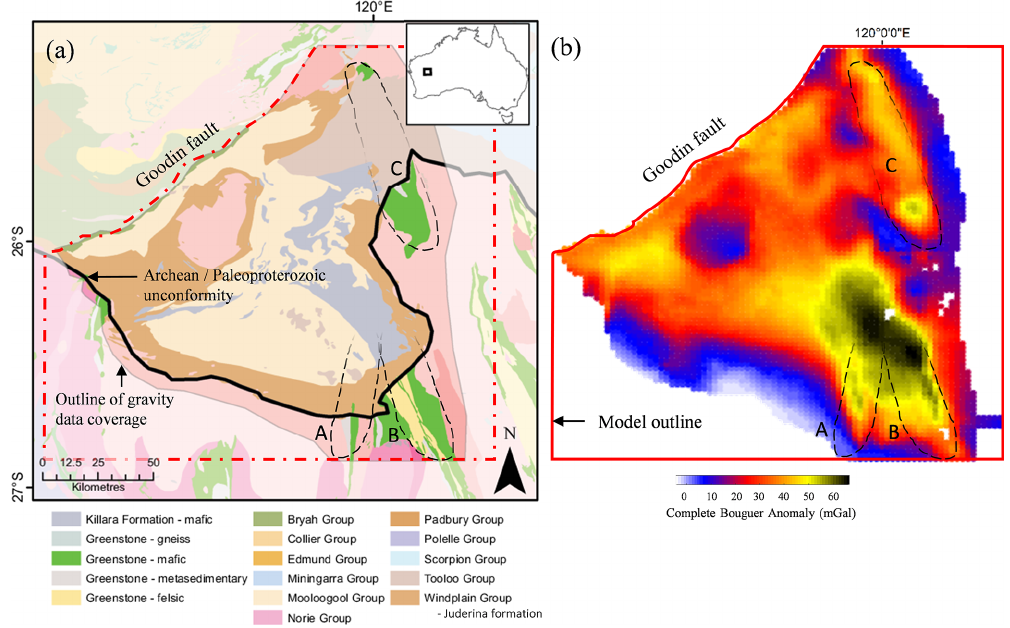
Figure 3. (a) Geological map of the area and (b) complete Bouguer anomaly (reproduced from Giraud et al., 2019a). The dashed red line outlines the modelled area. Capital letters “A”, “B” and “C” symbolize the possible outlines for the greenstone belts in the